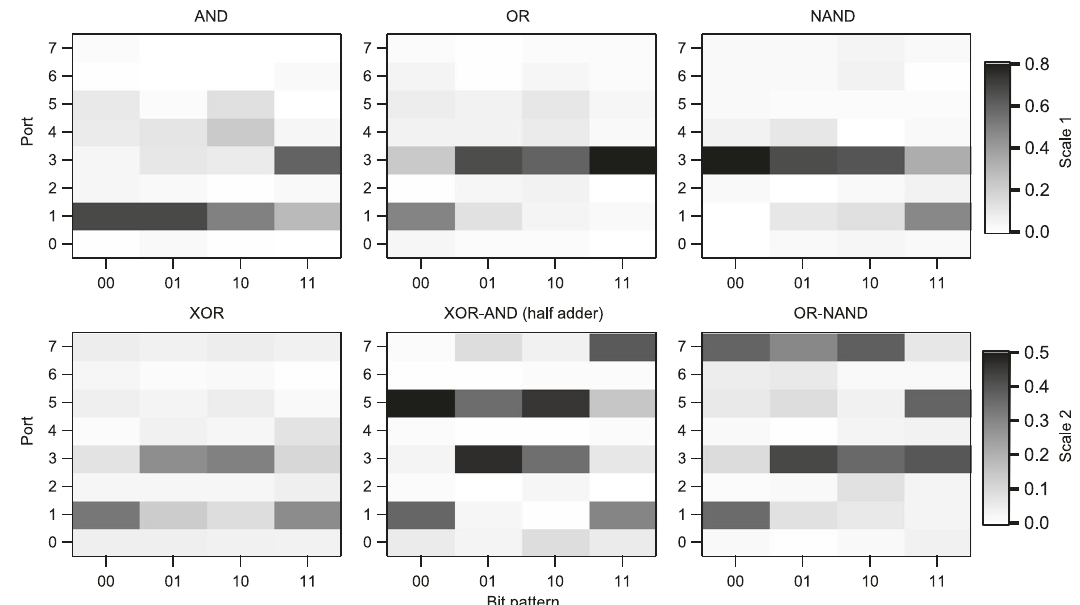
Fig. 4 Single and combinational Boolean logic operation experiment. Power maps of single logic (AND, OR, NAND, XOR) and combinational logics (XOR- AND, OR-NAND). All fi gures are obtained by BFO training. The ports 1 (and 5) and 3 (and 7) denote the logic values 0 and 1, respectively. Scale 1: